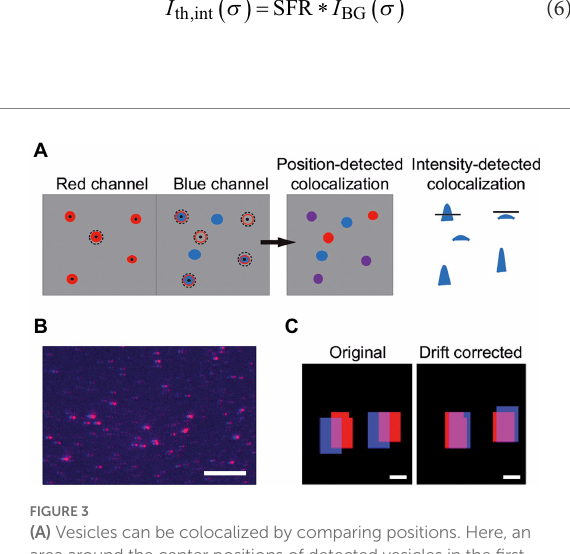
FIGURE 3 (A) Vesicles can be colocalized by comparing positions. Here, an area around the center positions of detected vesicles in the first channel is used to search for center positions in the second channel (position-detected colocalization). Colocalization can also be detected by comparing the integrated intensities over the same areas in the two channels. The mask from one channel is applied to the second cannel and I tot is calculated. The intensities that pass a SFR-based threshold (Eq. 6) are colocalized (intensity- detected colocalization). (B) Image of an overlay of the red and blue channels of a sample with 100% theoretical colocalization. All red spots are slightly shifted compared to the blue spots, indicating that drift correction is needed. The scale bar is 10 μ m. (C) Binary image of two detected spots before (left) and after (right) drift correction. The scale bars are 1 μ